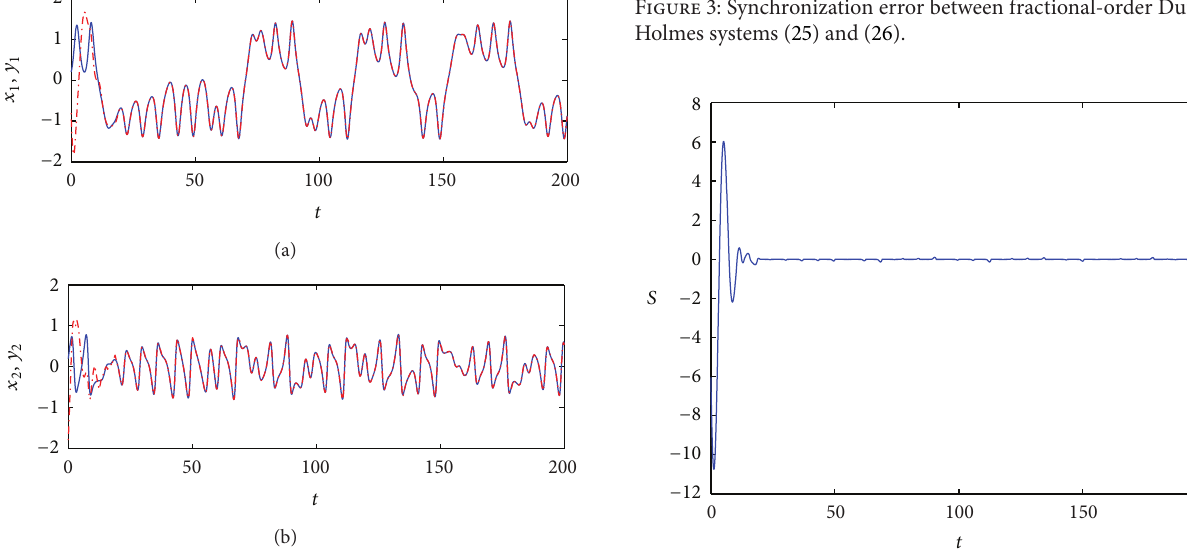
Figure 4: Switching surface 𝑆 of the sliding mode controller